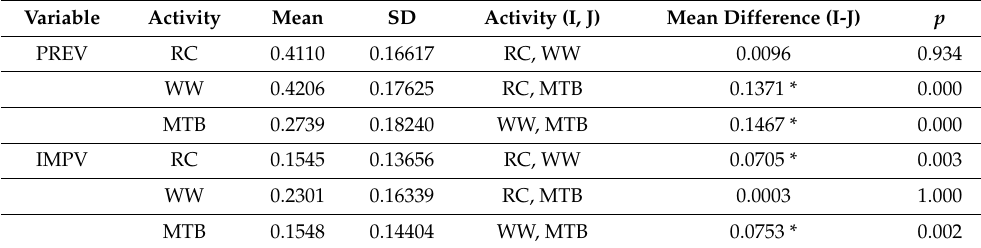
Table 5. Tukey HSD post hoc